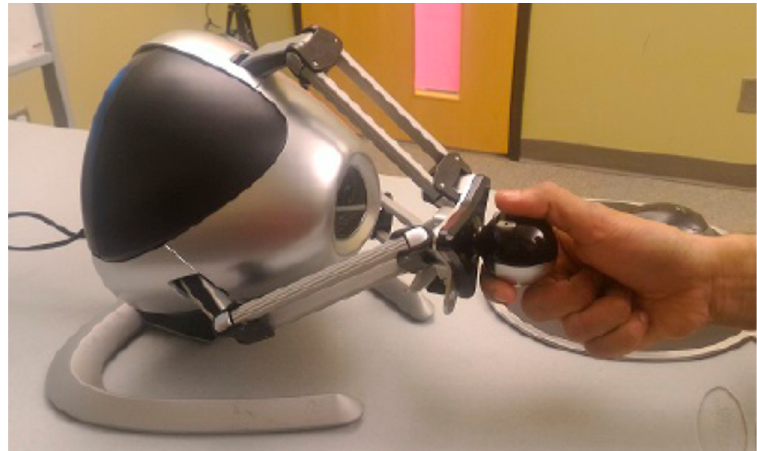
Figure 1. The Falcon haptic device.